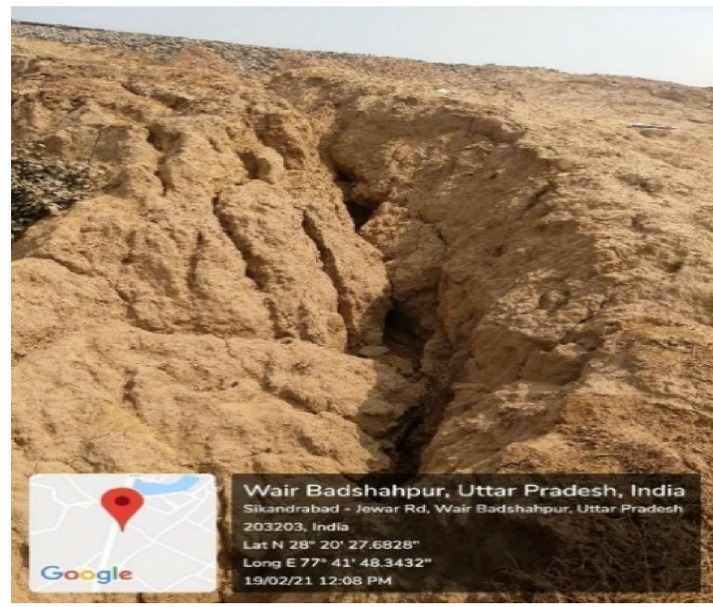
India. Cross-sectional details using drawings and real-life images are shown in Figs. 7 and 8, and physical dimensions are tabulated in Table